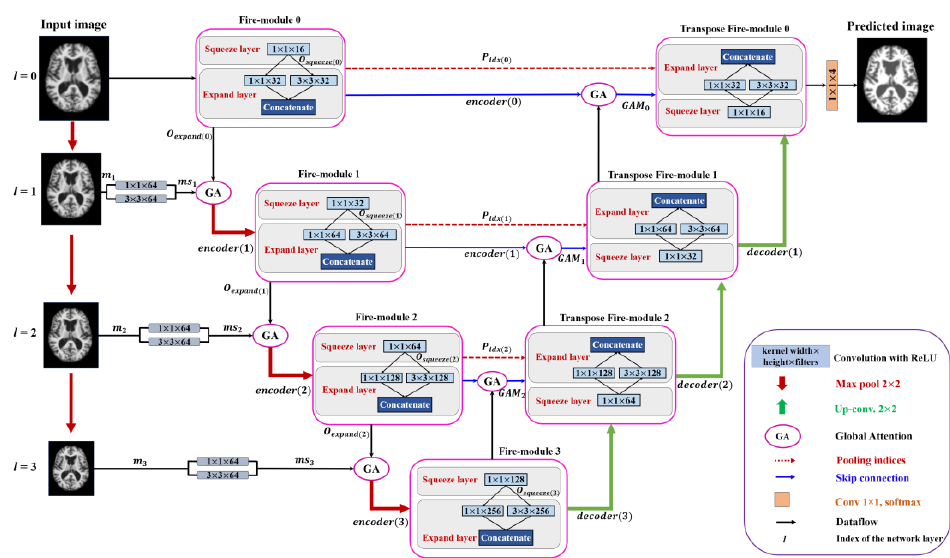
Figure 1. Overall framework of the proposed algorithm.